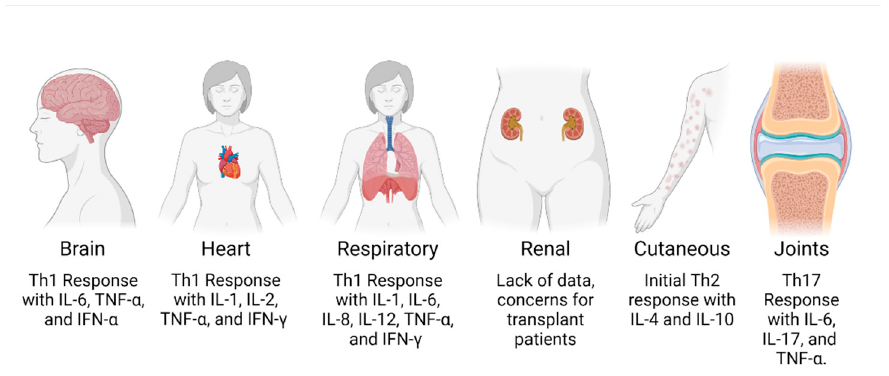
Figure 1. Generalized schematic of the major organ systems affected by CHIKV infection and their associated T cell and cytokine response. Figure generated in BioRender.